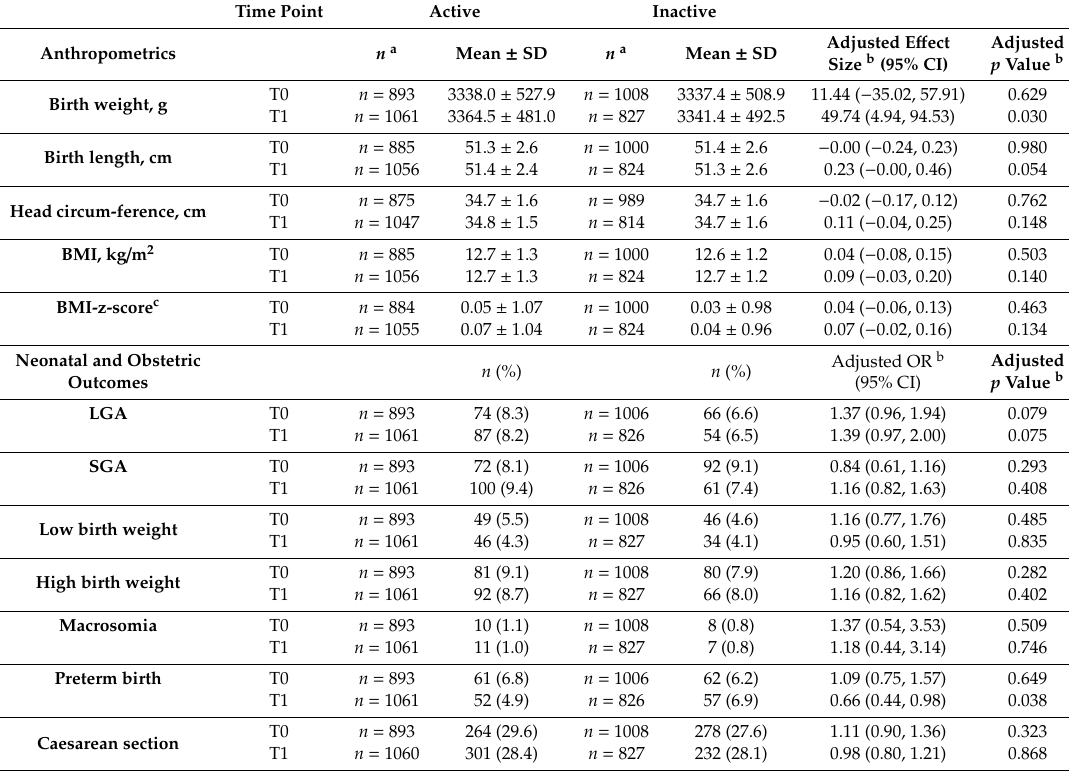
Table 2. Di ff erences between active and inactive women in infant anthropometrics, neonatal, and obstetric